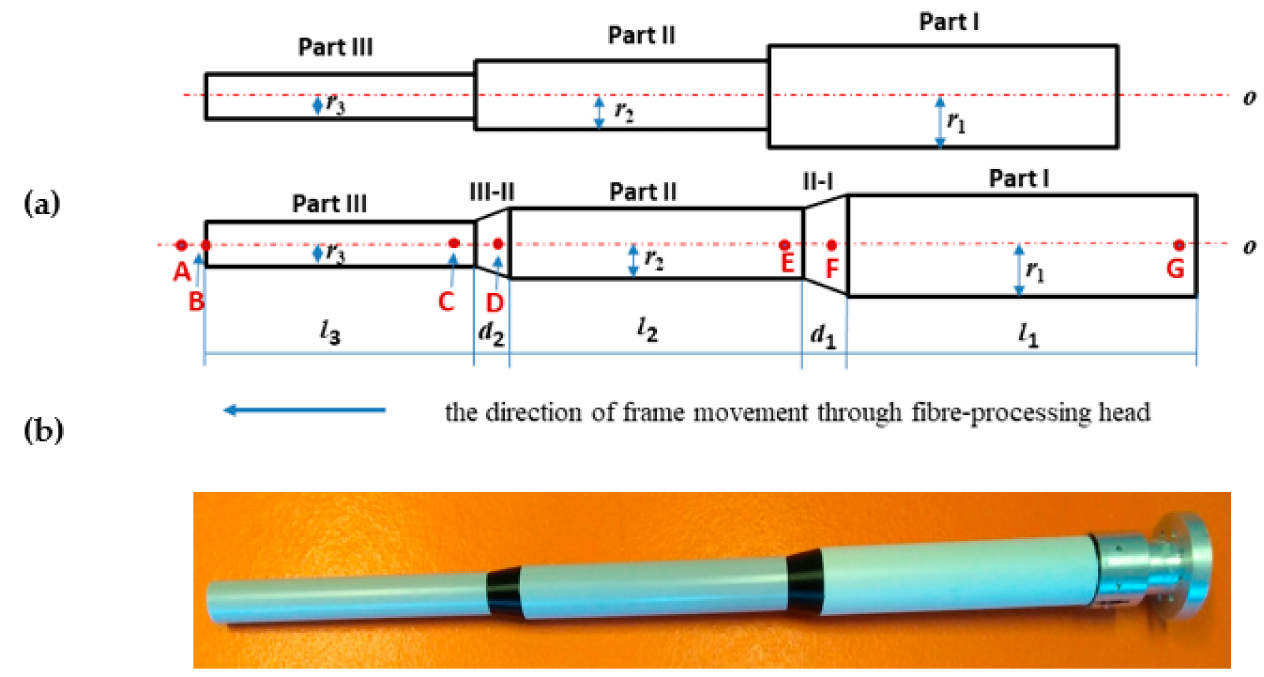
Figure 3. ( a ) Example of a longitudinal cross-section of a straight frame with three parts with different radii, jump transition between individual parts of the frame (( a ) upper), continuous transition between the individual parts of the frame (( a ) lower), and ( b ) test non-bearing polyurethane frame, continuous transition between the individual parts of the frame were created on a 3D printer. The metal part adjacent to the frame (in the right part of the picture) is used to attach the frame to the robot-end-effector